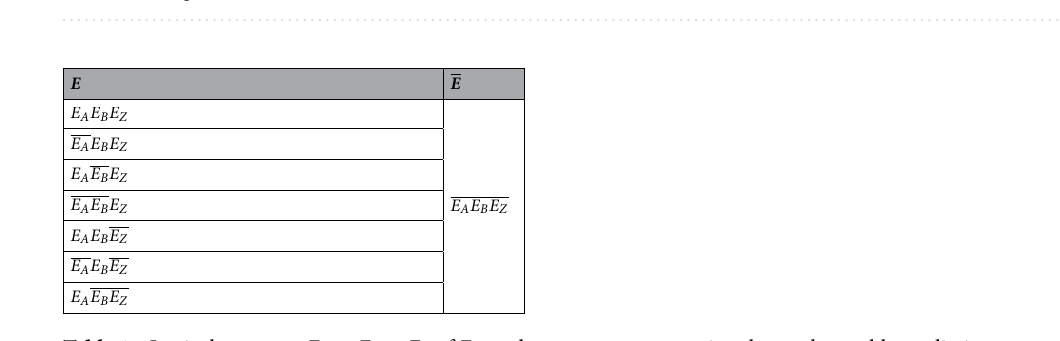
Figure 2. Sketch of the interaction scenarios. A and B are observed factors, Z accounts for unobserved factors and process, and E is the effect of interest. ( a ) Schematic representation of our limited information. The shaded area encloses the unobservable mechanism and background agents. Only factors A and B and the effect are observable. ( b ) No-interaction scenario. ( c ) Interaction scenario (there is a cross-over of the pathways from factors leading to the effect). (Draw with PowerPoint 23 ).